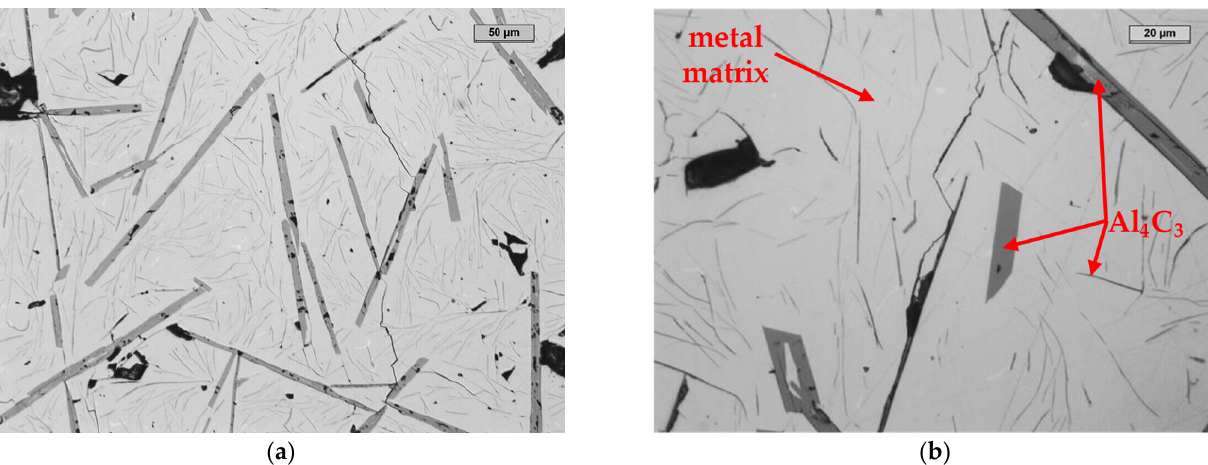
Figure 3. Microstructure (LM) of the specimens of the reference sample of high-aluminum cast iron, with visible fractures of the metal matrix ( a , b ).